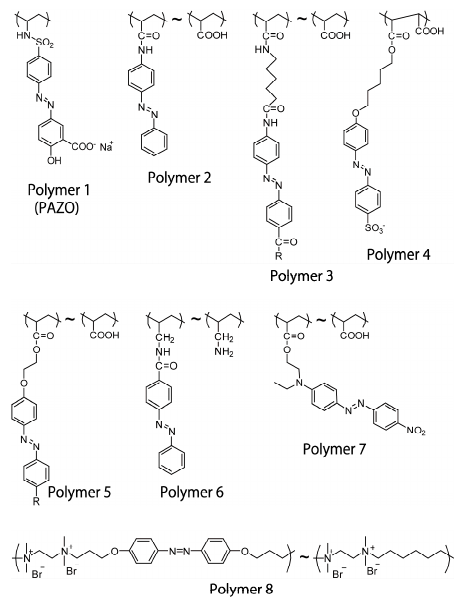
Figure 3. Chemical structures of azobenzene-modified polymers used for the construction of LbL films and microcapsules.